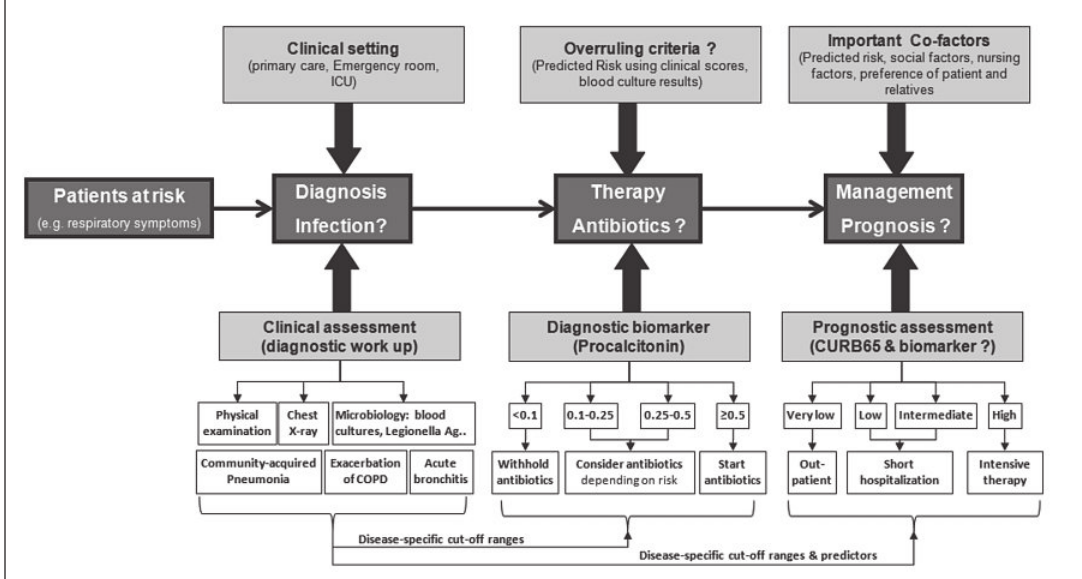
Diagnostic and prog- nostic biomarkers